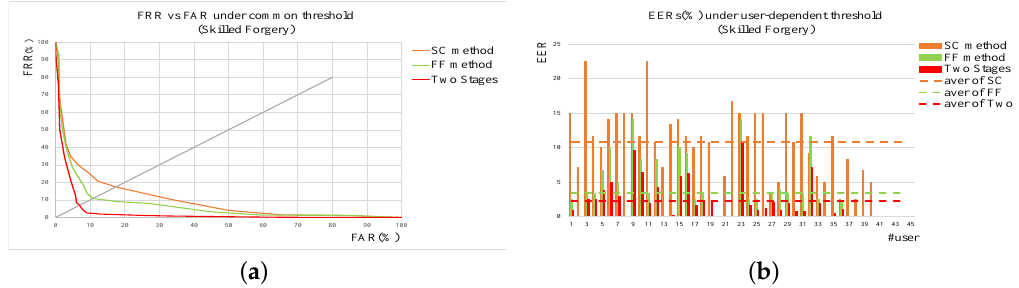
Figure 9. Results of SC, FF, and two-stage method on skilled forgery. ( a ) ROC under common threshold. ( b ) EER of each user under user threshold. In addition, those dotted lines are the average levels of corresponding methods.